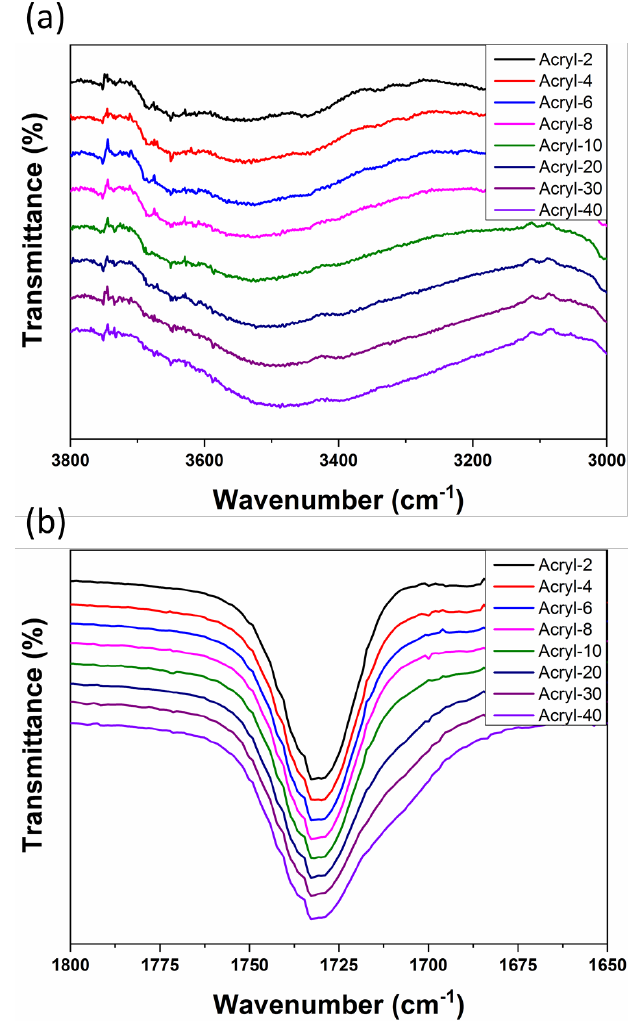
Figure 1. FT-IR spectrum of acrylic PSA films for HEA content: ( a ) O–H region; and ( b ) C=O region.